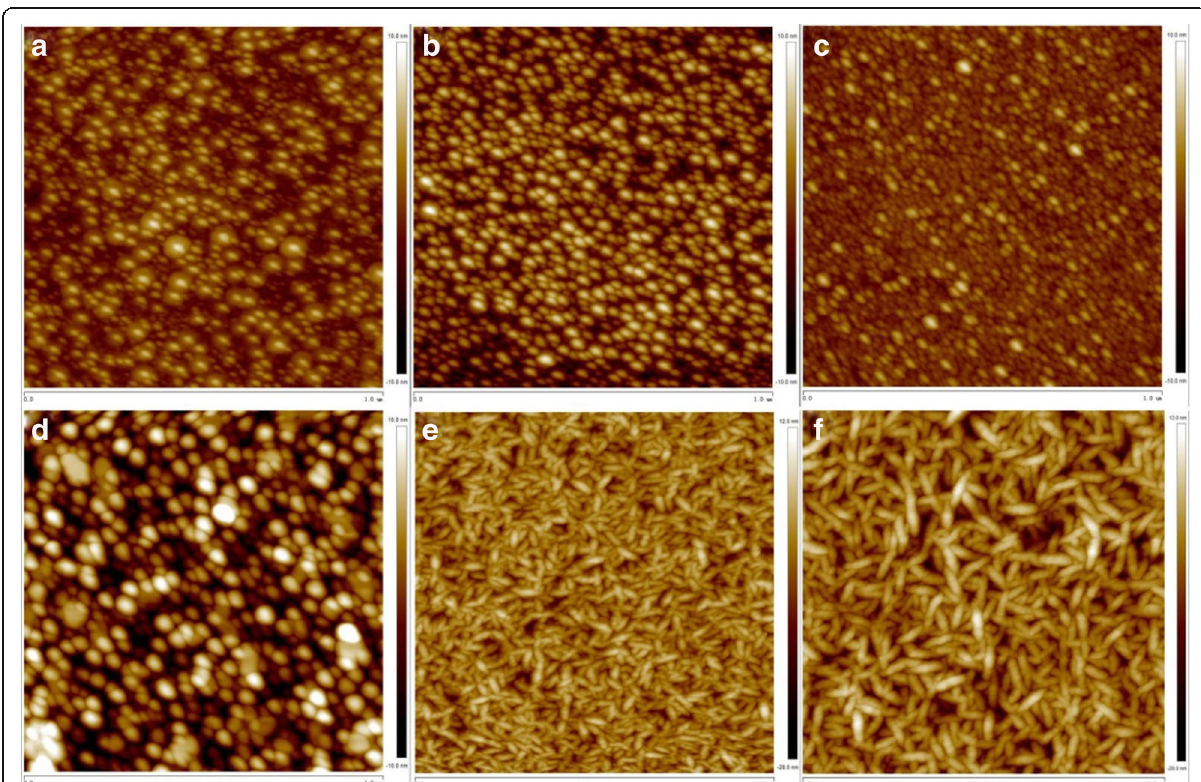
Fig. 4 a , b , c , d Surface morphologies of PAD-AZO films (1 μ m × 1 μ m) at different growth temperatures of 500, 600, 700 and 800 °C, respectively.